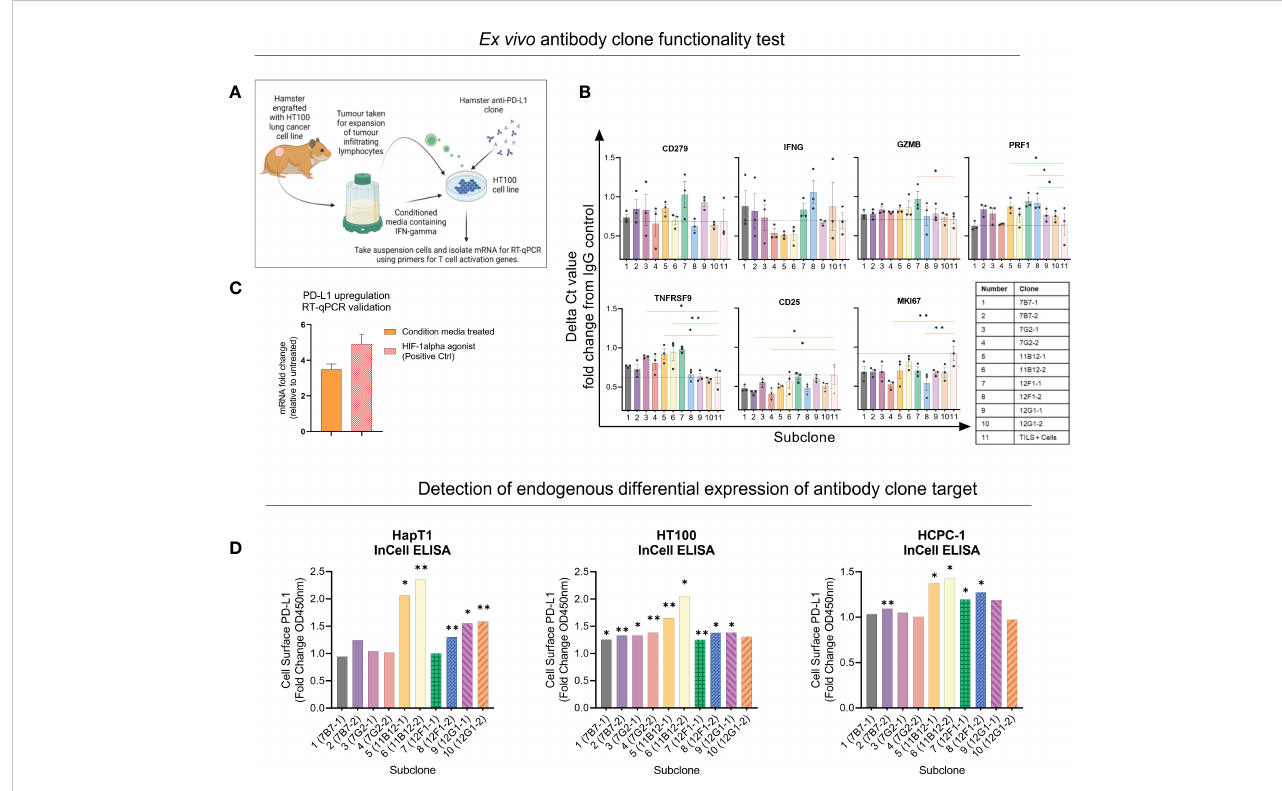
FIGURE 2 Selection of anti-Syrian hamster PD-L1 subclones by in vitro functionality. (A) Illustration of co-culture experiment design. (B) Seven T cell activation genes were measured from suspension cells isolated from the anti-PD-L1 subclone co-culture as measured by RT-qPCR. Values are presented as fold change from IgG control and the black dotted horizontal line represents the ‘ baseline ’ of HT100 + TILs without subclone. (C) Validating upregulation of endogenous PD-L1 on HaPT1 by RT-qPCR following exposure to conditioned media with a HIF-1 agonist as a positive control. (D) Detection of endogenous differential PD-L1 expression on the surface of three Syrian hamster cancer cell lines by anti-PD-L1 subclones as measured by In-Cell ELISA. Diluted conditioned media was used to upregulate PD-L1 and was compared to untreated control. PD-L1+ signal was measured by absorbance OD450 of HRP-conjugated antibody detecting mouse IgG. Clones able to detect differential expression of PD-L1 were considered more speci fi c for PD-L1 detection. The absorbance values were normalized to cell number as measured by Janus Green Whole-Cell Stain. Data and error bars are presented as mean ± SEM. Statistical signi fi cance was determined by unpaired t-test with Welch ’ s correction. *p < 0.05, **p <